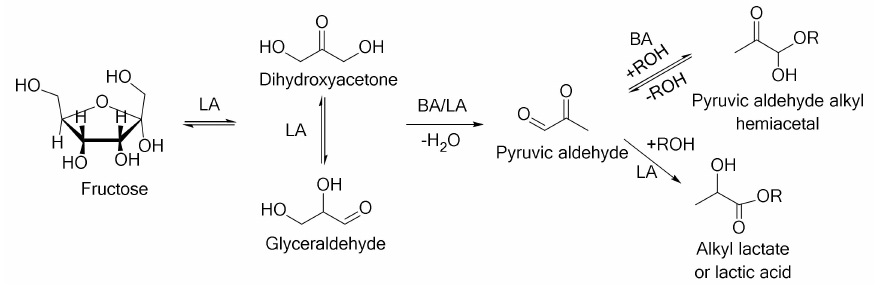
Figure 11. Reaction pathways for the conversion of dihydroxyacetone to alkyl lactates/lactic acid. LA, Lewis acid; BA, Brønsted